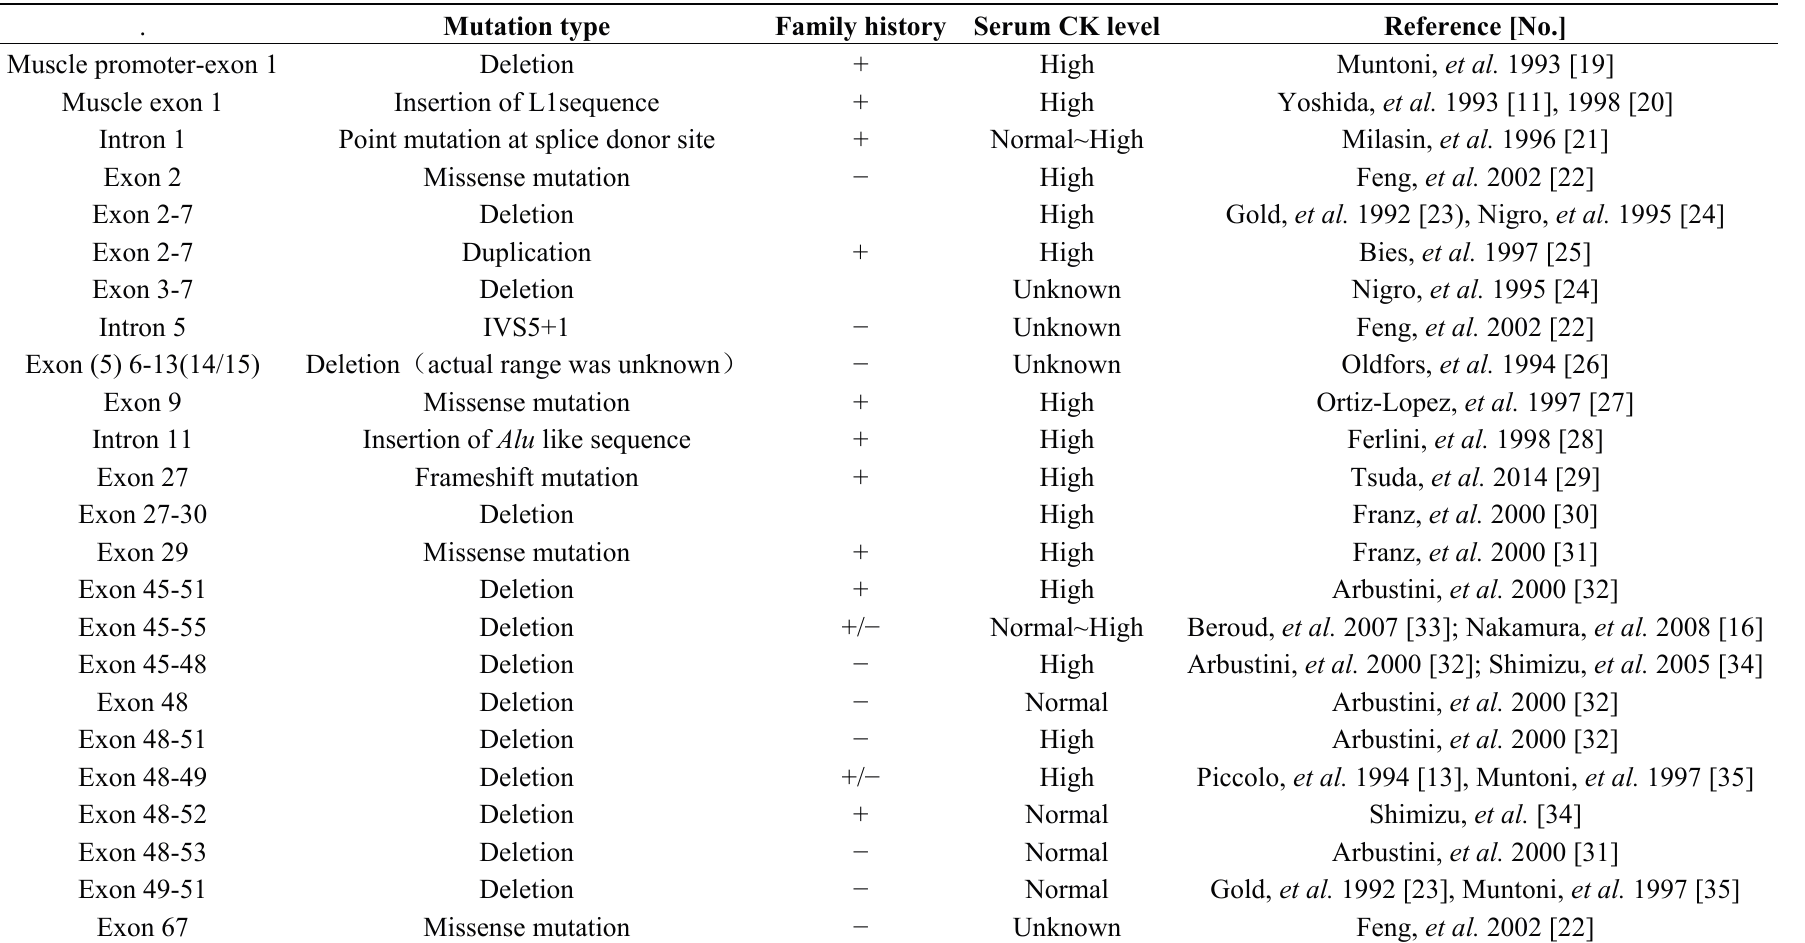
Table 1. X-linked dilated cardiomyopathy and dilated cardiomyopathy with mild Becker muscular dystrophy having the DMD mutations.